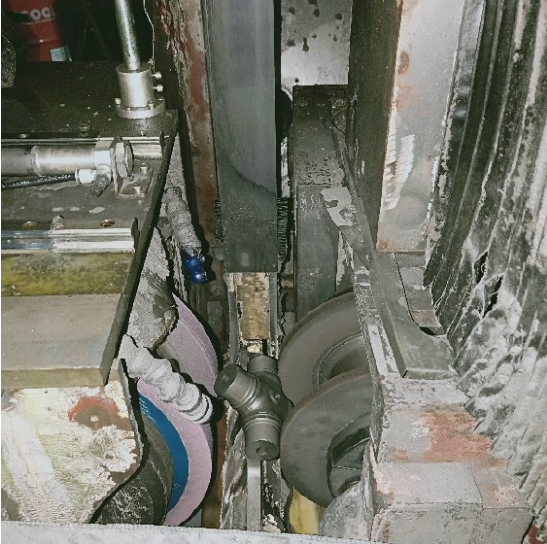
Figure 7. The picture of the grinding machine and product.